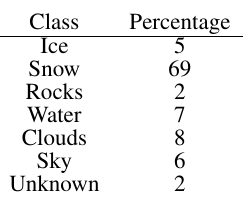
Figure 1. Example image triple from Antarctic TMA, consisting of a left-oblique, an on-nadir and a right-oblique image. prevalent in the training data and is not a valid output class. It is used as a class, if the pixels cannot be assigned with a certain confidence to another class.